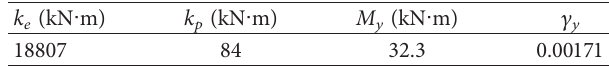
Table 6: Improved spring properties of the connections in the